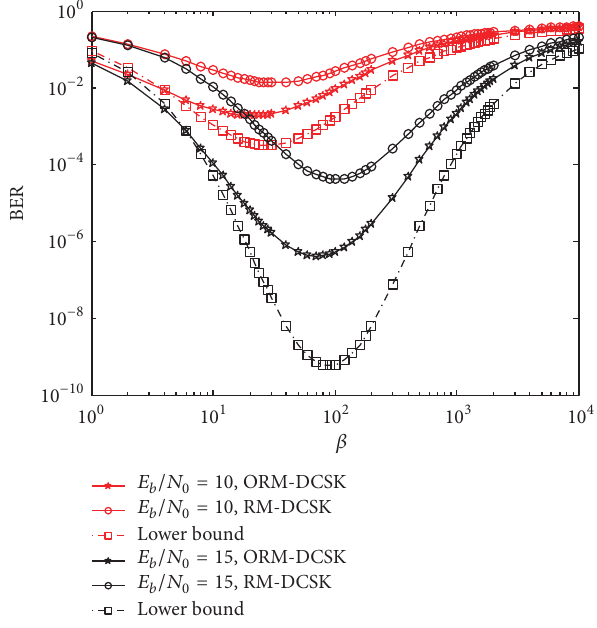
Figure 6: BER performance versus spreading factor 𝛽 .